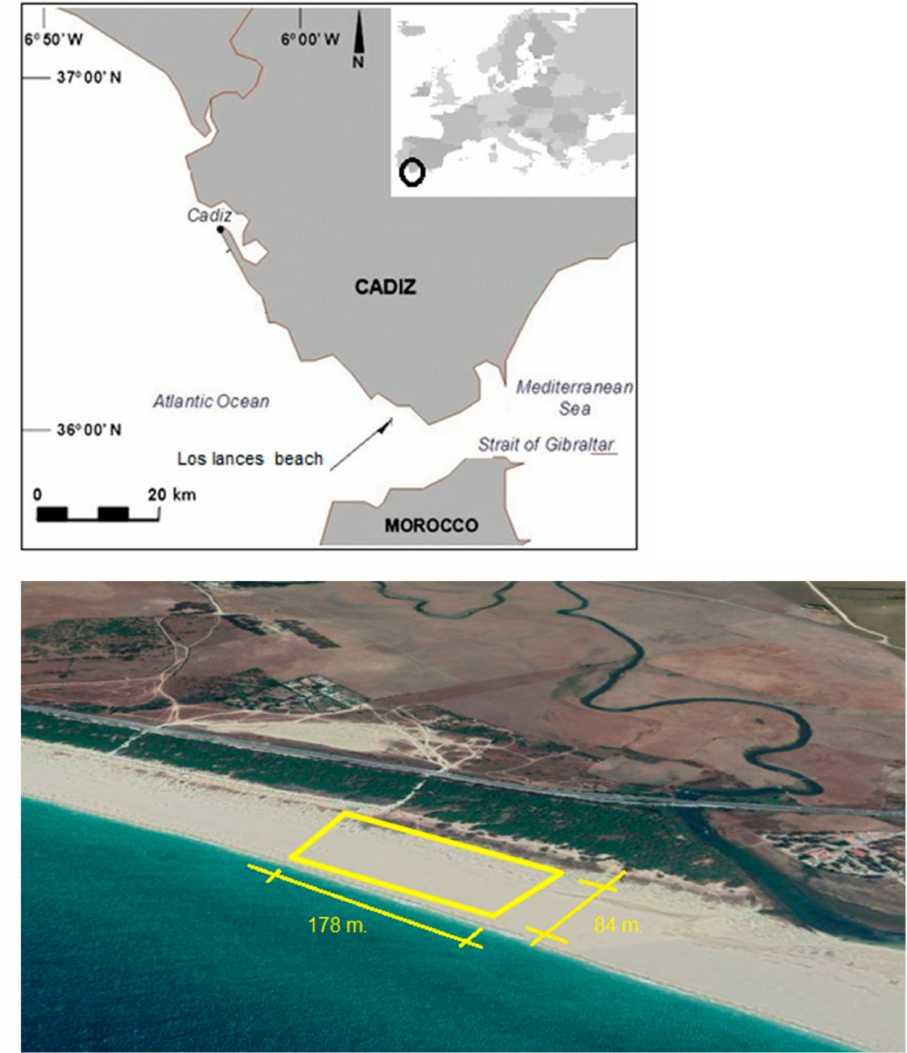
Figure 2. Location of the study